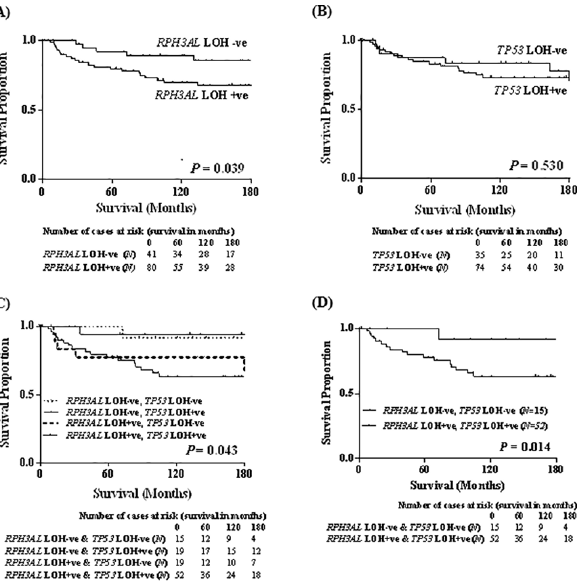
Fig 2. Prognostic significance of RPH3AL LOH. Kaplan-Meier survival analyses of (A) LOH at 17p13 . 3 locus of RPH3AL , (B) LOH at 17p13 . 1 locus of the TP53 , and (C) combinations of LOH at RPH3AL and TP53 , and (D) survival proportions of patients with LOH at both RPH3AL and TP53 loci versus the patients without LOH at both loci. Log-rank P-values and the number of patients at risk ( N ) in each group at different time periods. Positivity of RPH3AL LOH, but not TP53 LOH, was associated with patient poor survival. Patients with LOH positivity at both RPH3AL and TP53 loci had poor survival relative to patients with LOH at TP53 and without LOH at RPH3AL (P = 0.008) as well as those that were LOH negative at both loci (P = 0.014). Also, the subgroup with LOH positive at RPH3AL and LOH negative at TP53 locus had poor survival, similar to the patients that were positive at both loci (P = 0.101), suggesting that RPH3AL LOH is associated with patient